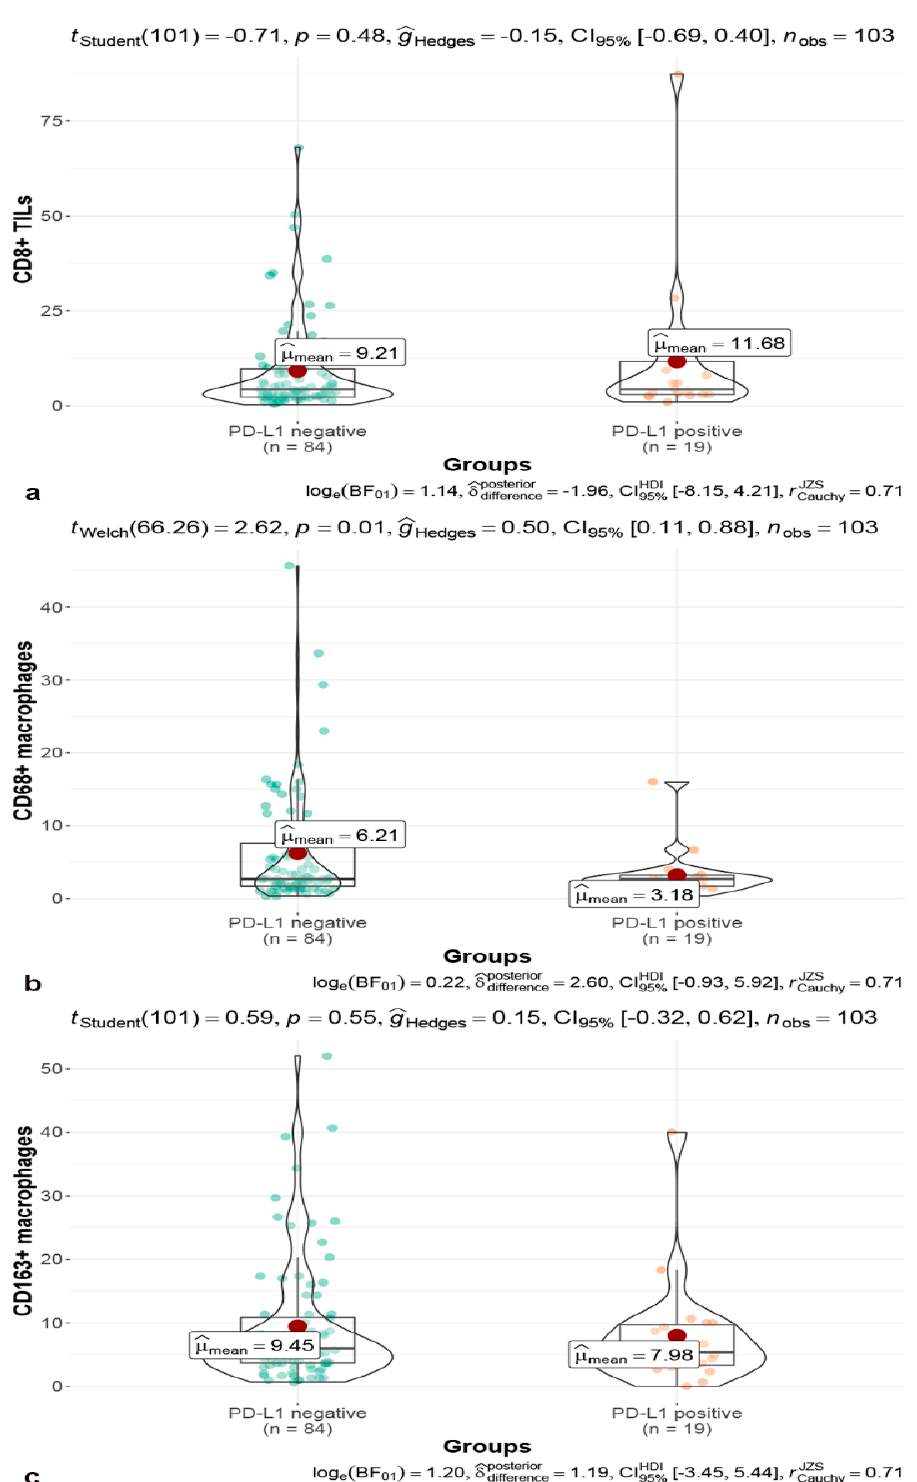
Figure 4. Unpaired t-test performed between the PD-L1 positive and PD-L1 negative groups in CD8+ TILs ( a ); the infiltration of CD68+ macrophages difference between PD-L1 positive and PD-L1 negative groups were calculated with an unpaired t-test ( b ); Student’s t-test between the PD-L1 positive and PD-L1 negative groups in CD168+ macrophages ( c ).